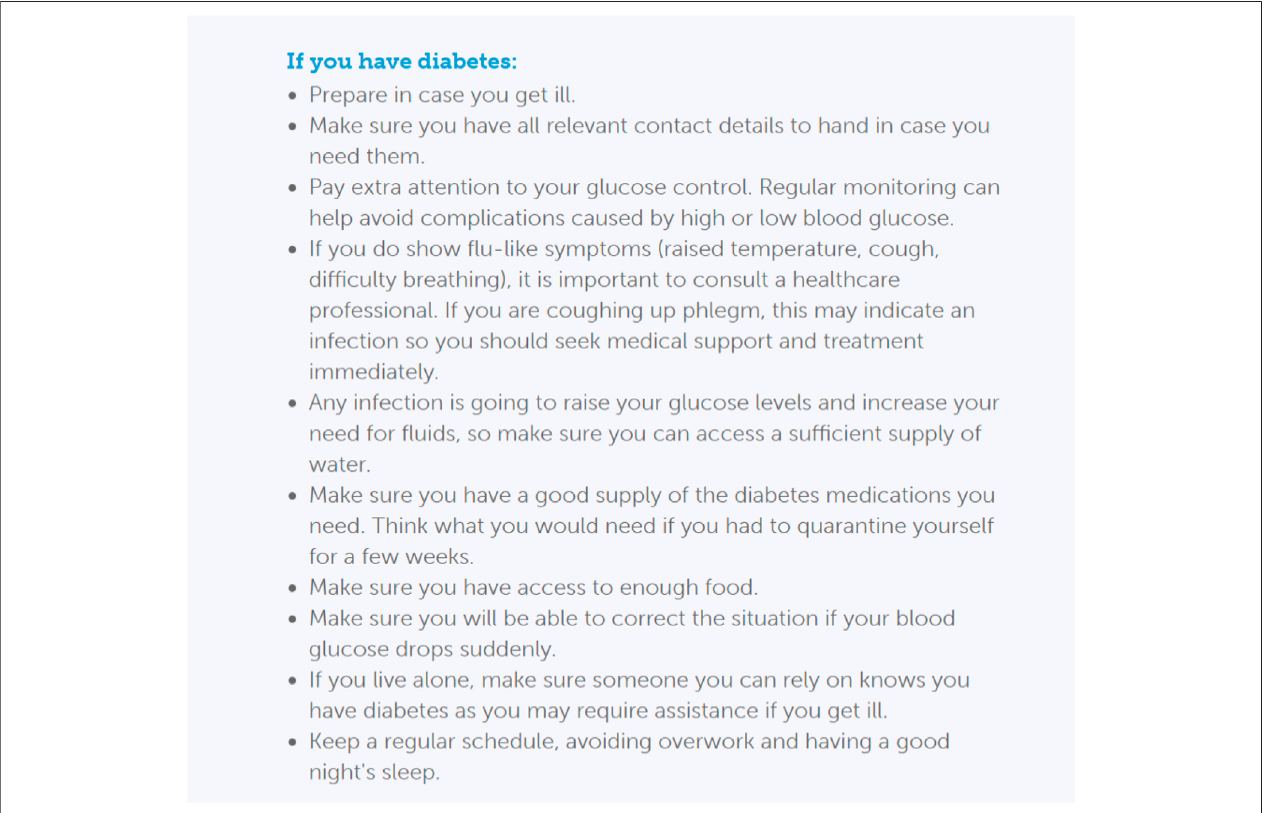
FIGURE 1 | IDF instructions for COVID-19 and diabetes (International Diabetes Federation, 2020).